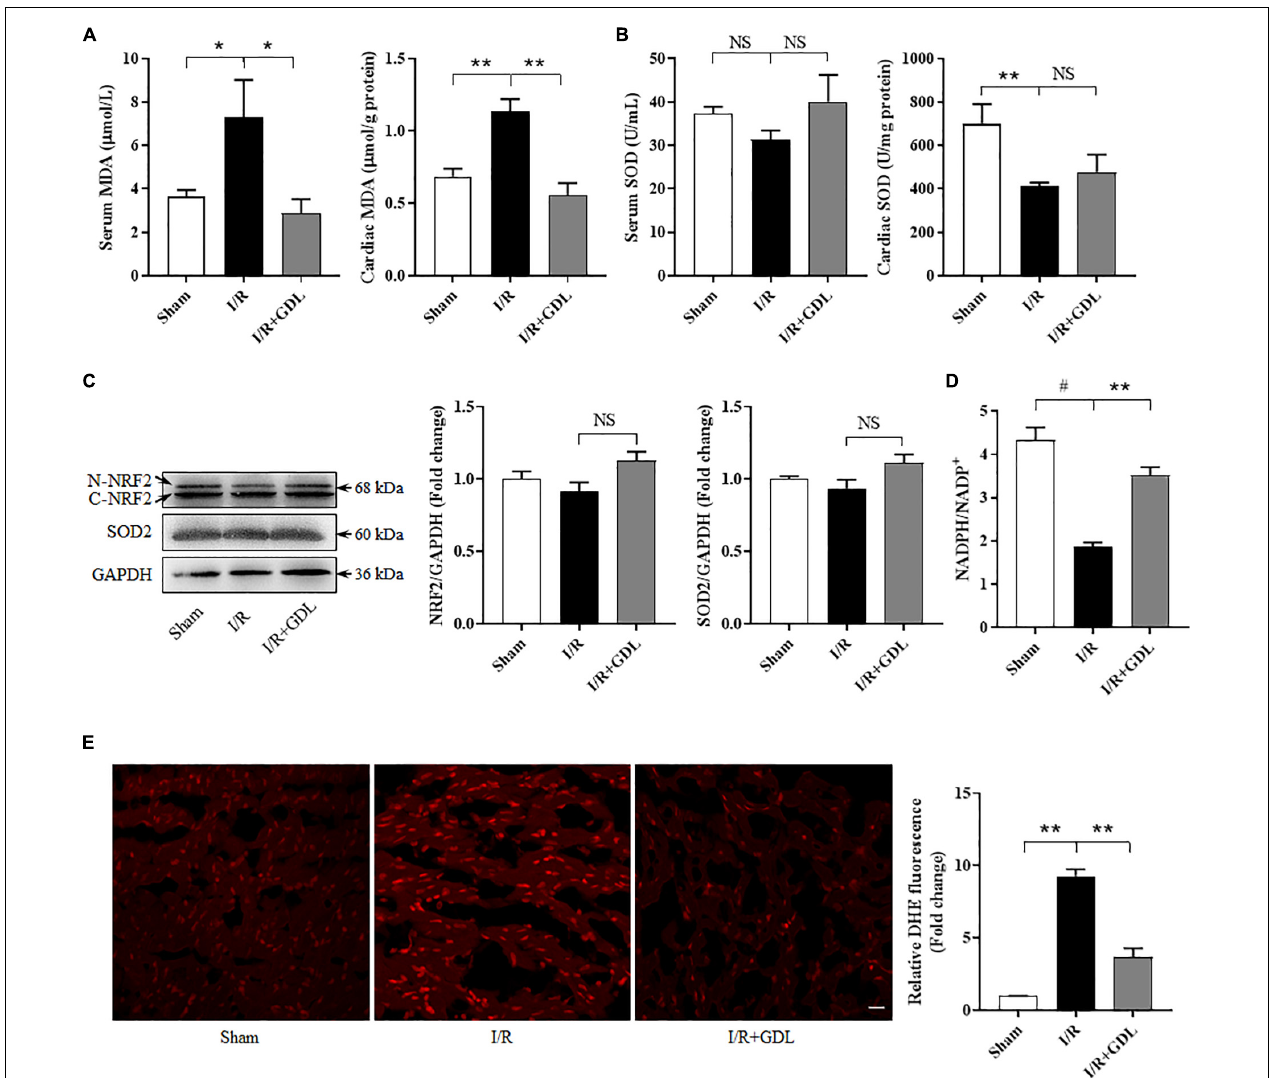
FIGURE 3 | D-glucono-1,5-lactone attenuated reperfusion-induced oxidative stress. (A) MDA levels in serum and cardiac tissue in sham, I/R, and I/R + GDL groups ( n = 4–6). (B) SOD activities in serum and cardiac tissue in sham, I/R, and I/R + GDL groups ( n = 6–7). (C) Representative images and Western blot analysis of NRF2 and SOD2 expression in sham, I/R, and I/R + GDL groups ( n = 5). (D) NADPH/NADP + ratio among groups ( n = 3–4). (E) DHE staining of heart tissue section among groups ( n = 3; scale bar = 20 µ m). * P < 0.05, ** P < 0.01, and # P < 0.001 between indicated groups. NS, not